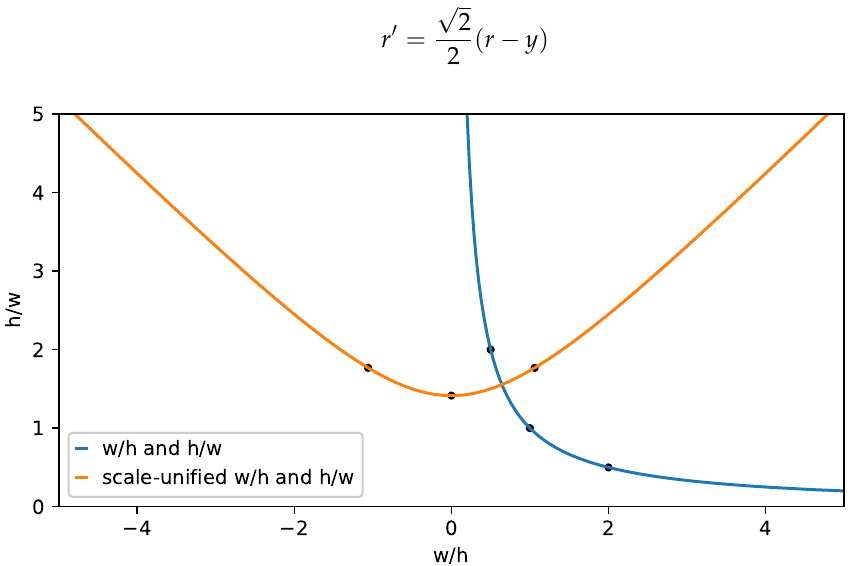
Figure 5. The scale of aspect ratio in different objects is unified after being